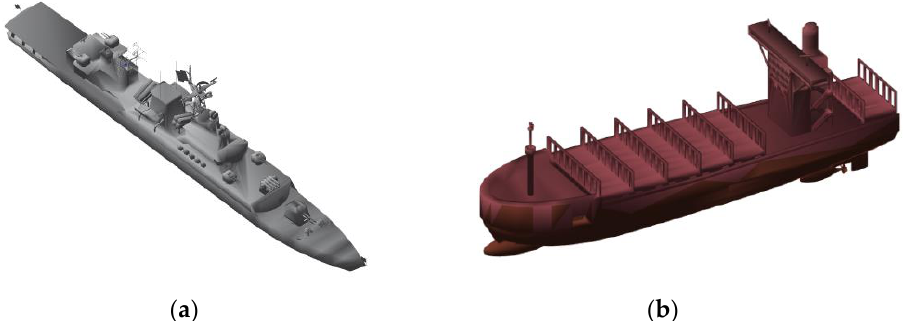
Figure 3. The final ship models. ( a ) The warship. ( b ) The cargo ship.